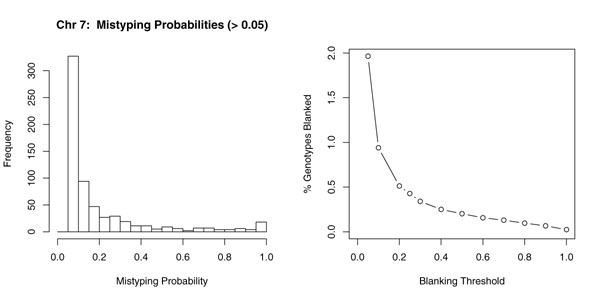
Distribution of double-recombinant genotyping errors The distribution of mistyping probabilities for the markers in chromosome 7 is shown on the left, and the proportion of genotypes blanked on the right, as determined by the mistyping probability thresholds on the x-axis. We chose to blank genotypes with mistyping probabilities greater or equal to 0.25.